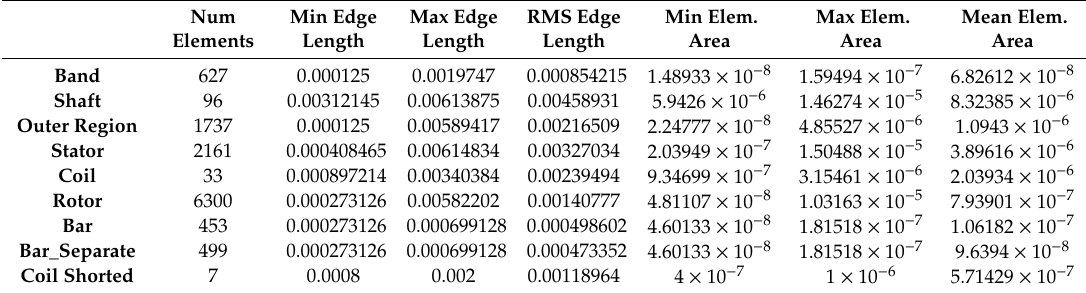
Table 2. Mesh parameters of the FEM